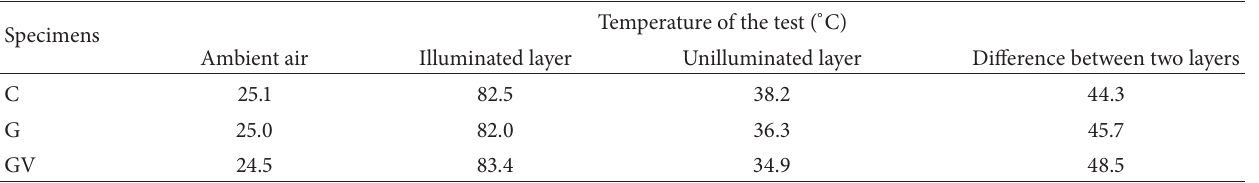
Table 3: The temperature of specimens after 12 hours